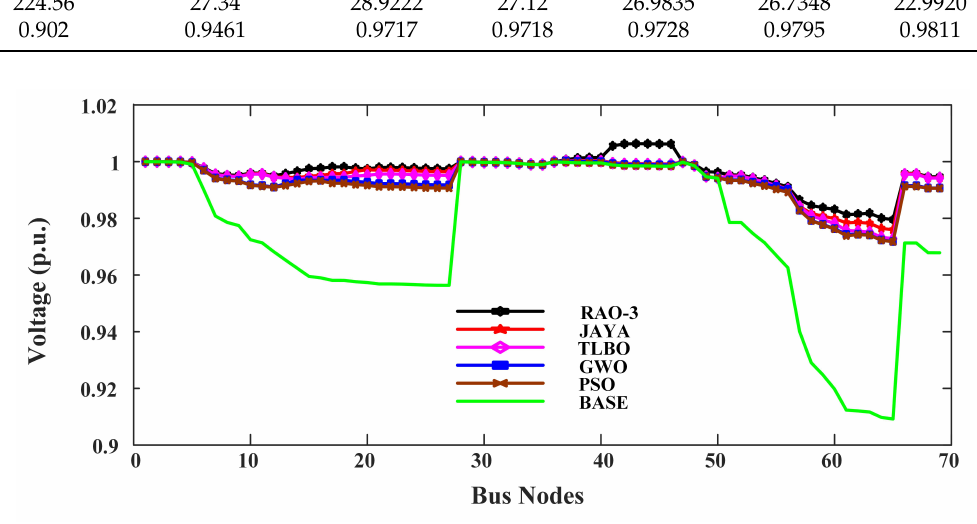
Figure 9. Voltage Curve.